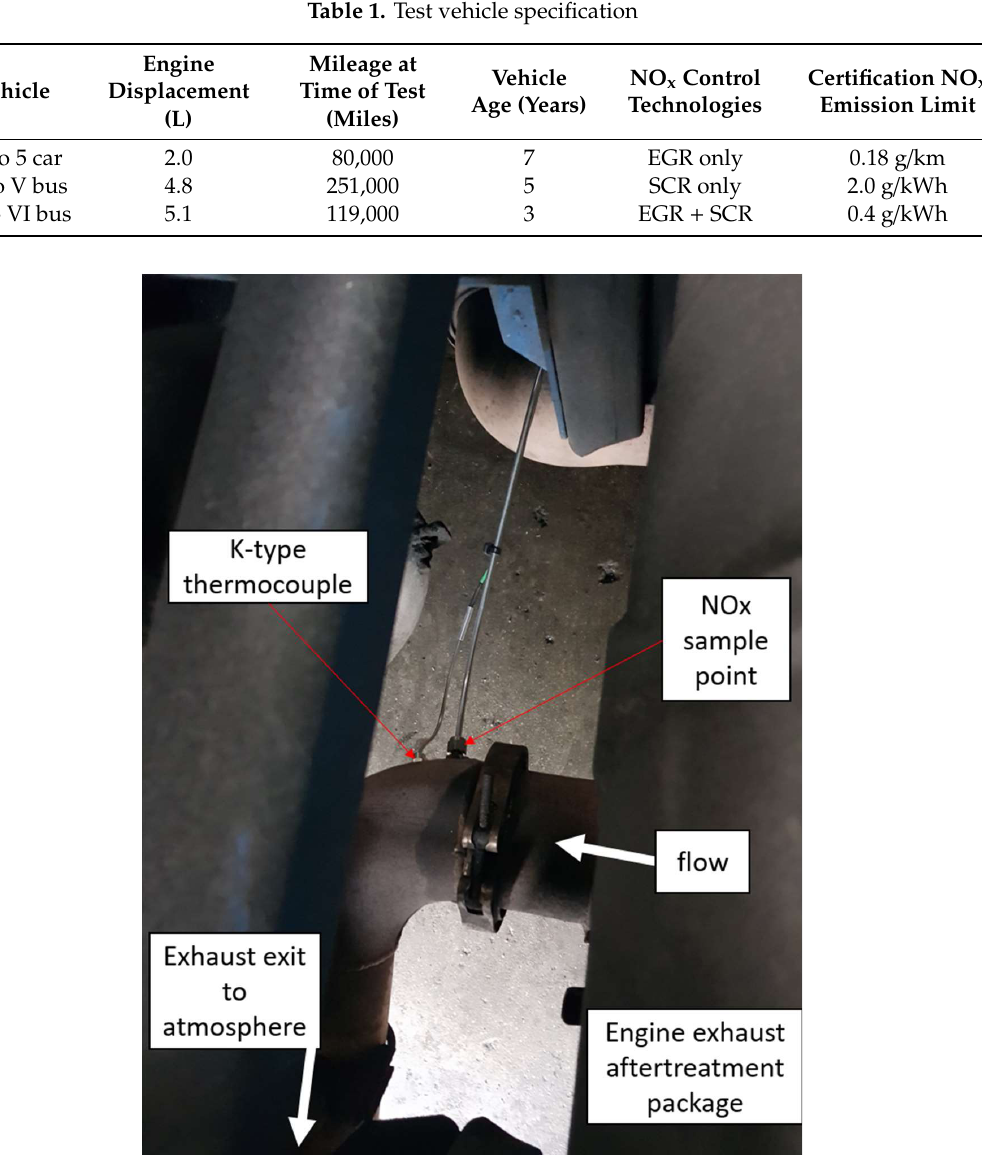
Figure 3. NO x sample point and thermocouple location on the Euro VI bus. Table 1. Test vehicle specification